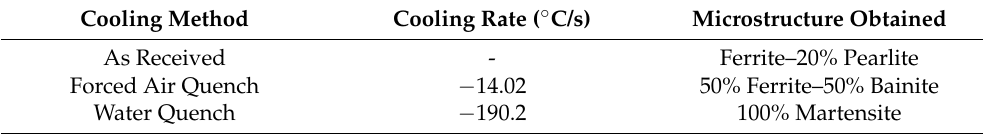
Figure 1. CCT curve obtained from JMatPro for Variant 2, the assumed prior austenite grain size 25 mm. Table 2. Cooling rates and the corresponding microstructures obtained from the Variant 2 Gleeble tests.